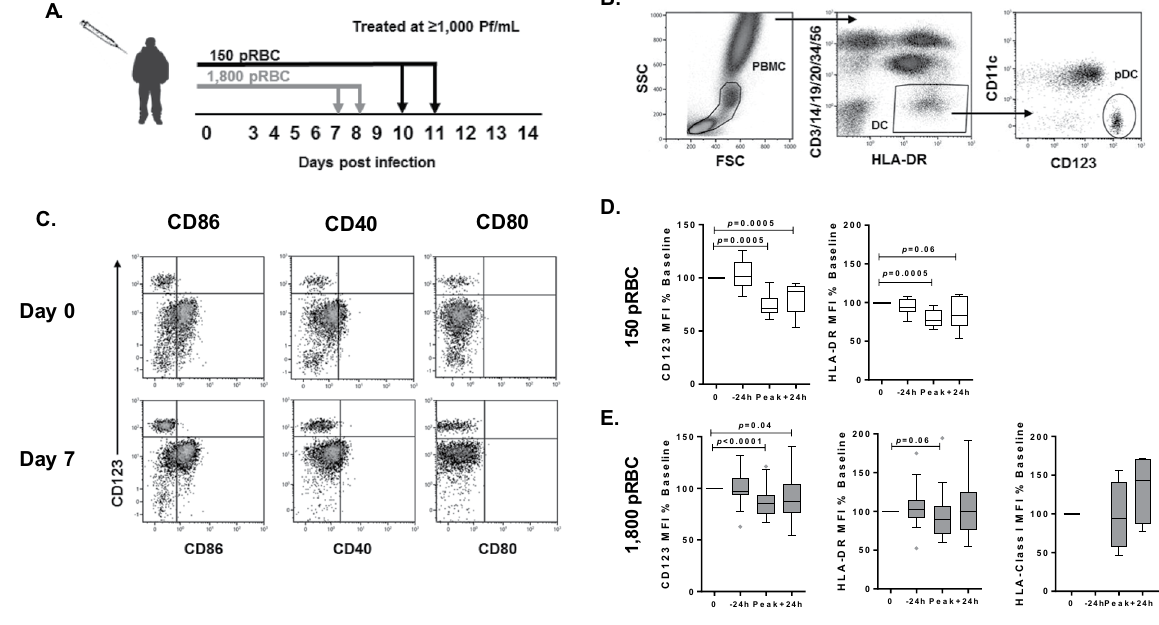
Figure 1. Circulating pDC are not activated in P. falciparum CHMI. ( A ) Schematic of clinical trial cohorts 150 pRBC (black) and 1,800 pRBC (grey), arrows indicate antimalarial treatment. ( B ) Fresh whole blood gating strategy for pDC. pDC were identified as negative for lineage markers (CD3, CD14, CD19, CD20, CD34 and CD56), HLA-DR + (2 nd panel), CD11c − and CD123 + (3 rd panel). ( C ) Representative flow cytometry plots from one participant showing CD86, CD40 and CD80 pDC expression before infection (day 0) and at peak-infection. Gated on total DC as shown in Fig. 1B 2 nd panel. ( D ) Longitudinal pDC CD123 and HLA-DR expression after 150 pRBC infection. ( E ) Longitudinal pDC CD123, HLA-DR and HLA-A,B,C expression after 1,800 pRBC infection. Box plots show the minimum, maximum, median and interquartile range for data from all participants (turkey plot). Abbreviations FSC, forward scatter, SSC, side scatter, MFI, median fluorescence intensity.